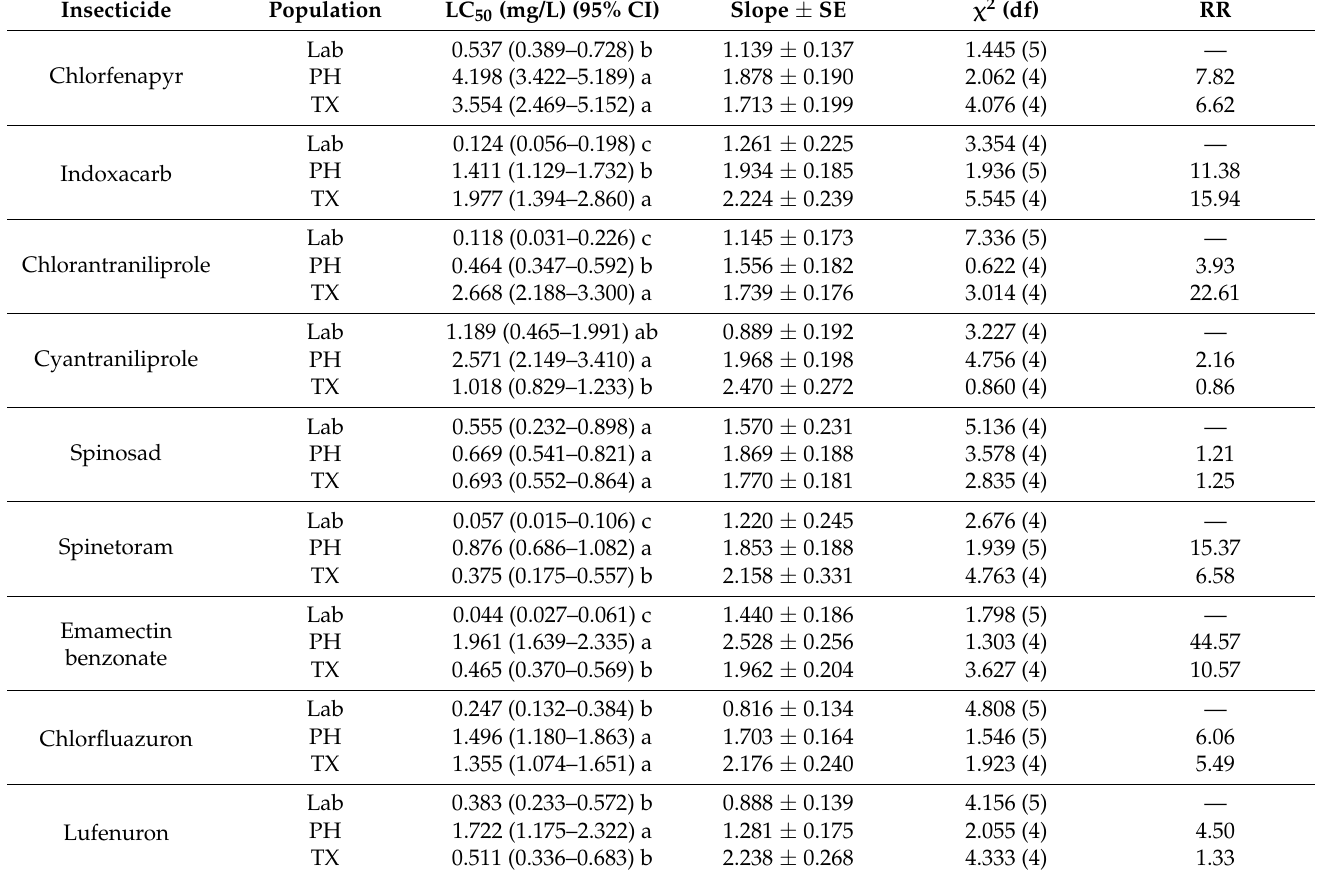
Table 3. Resistance of two field populations of Spodoptera exigua against eleven